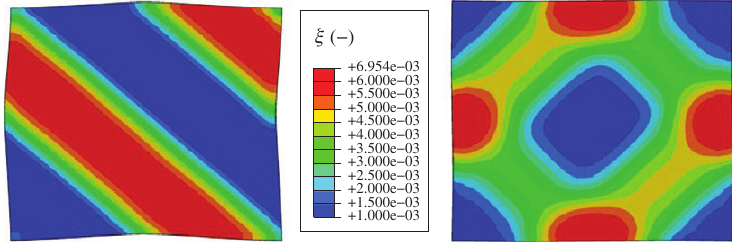
= 8% for sample with 11